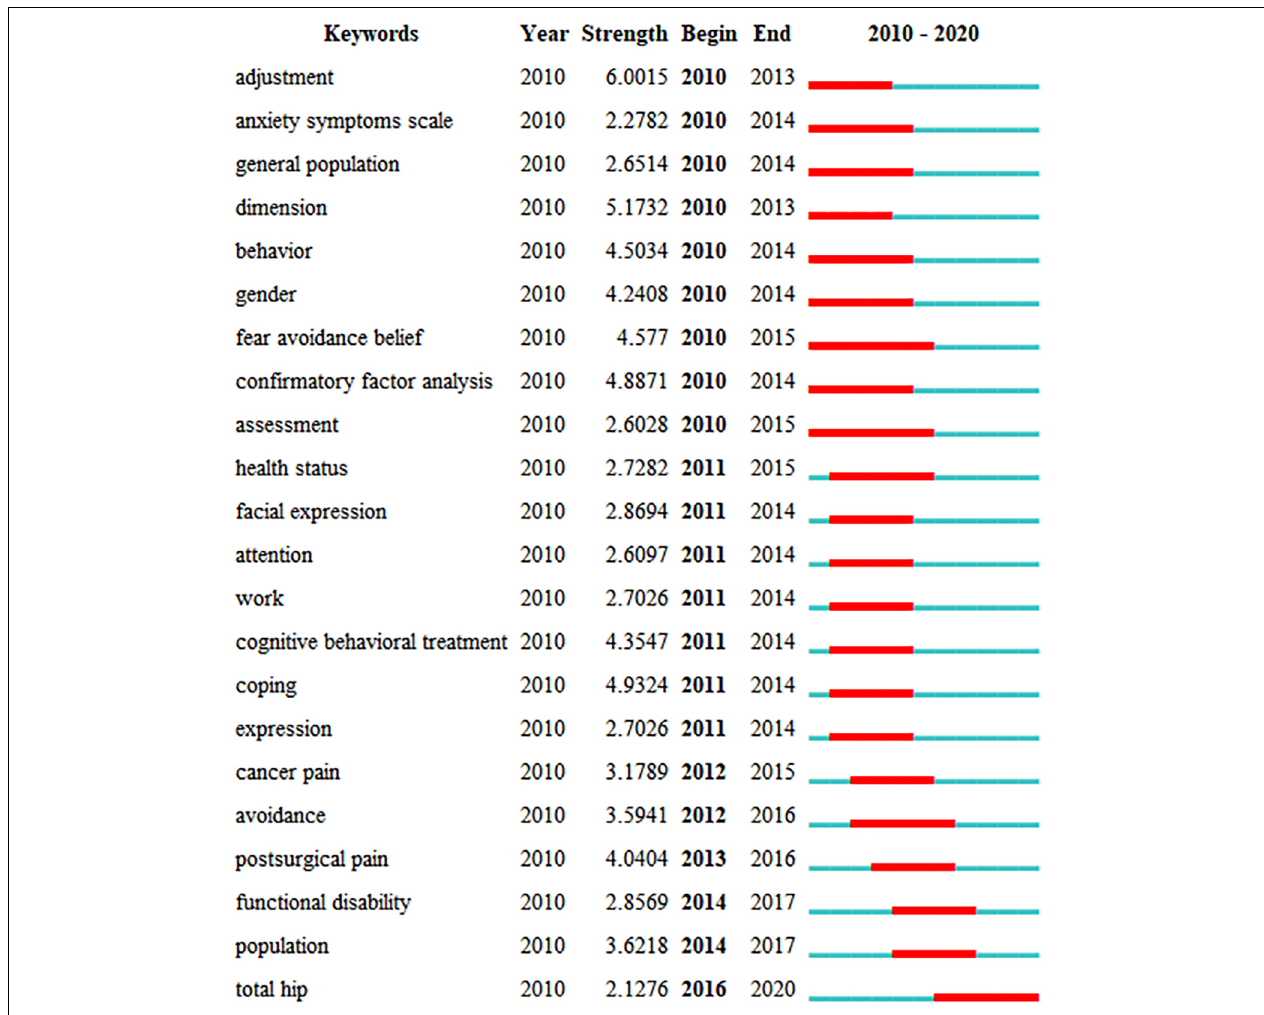
FIGURE 7 | Top 22 keywords with the strongest citation